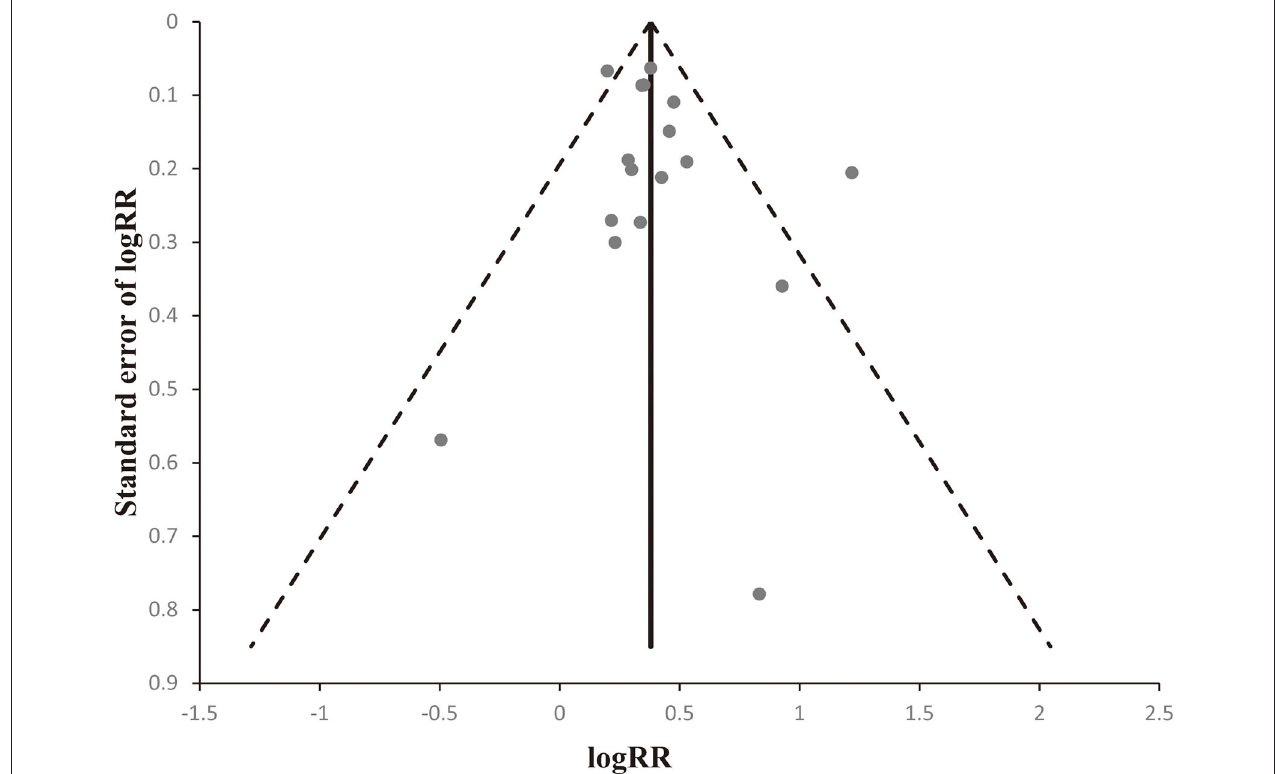
FIGURE 5 | Begger’s funnel plots to evaluate publication bias. The shape of the funnel plot was obviously symmetrical.